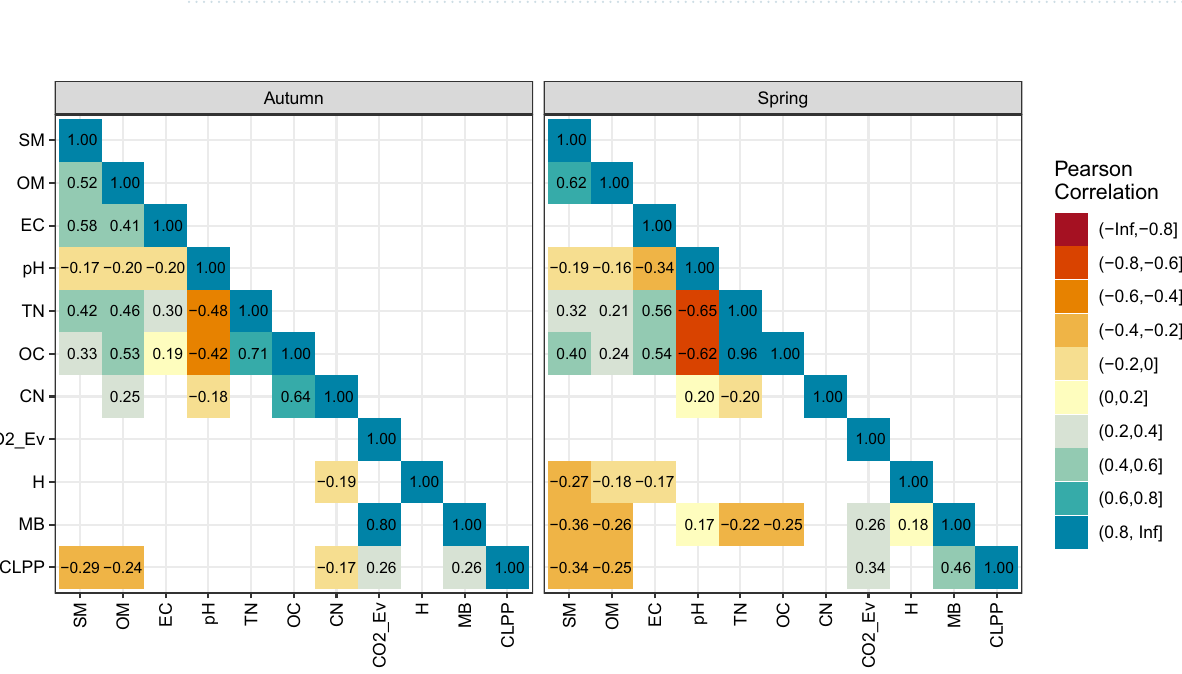
Table 4. Standardized correlations in Autumn between the four canonical variables in the different columns and the variables in the two sets.